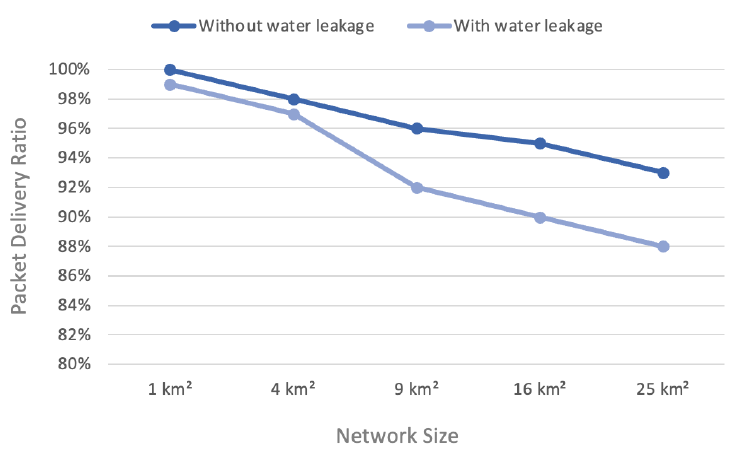
Figure 5. Packet delivery ratio (PDR) versus network